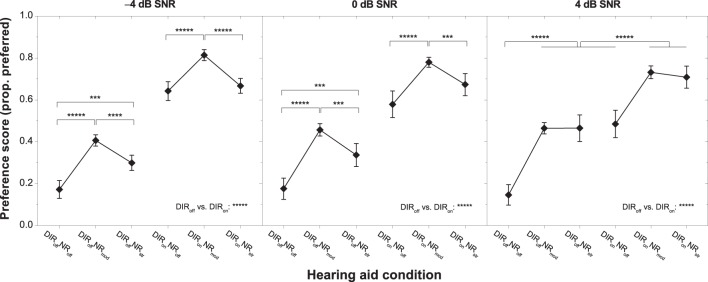
Mean preference scores for the six HA conditions and SNRs of −4 dB (left panel), 0 dB (middle panel), and 4 dB (right panel). Error bars show 95% confidence intervals. Horizontal bars denote significant differences (***p < 0.001, ****p < 0.0001, *****p < 0.00001).